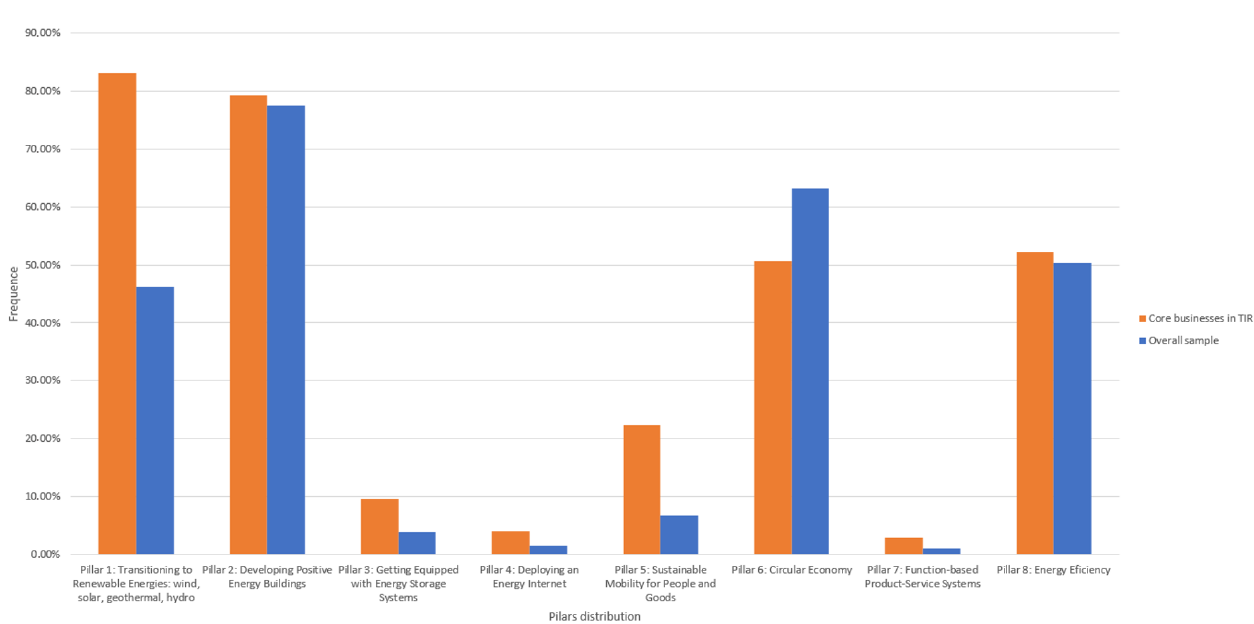
Figure 2. Distribution of activities and employment growth rates from 2013 to 2018.